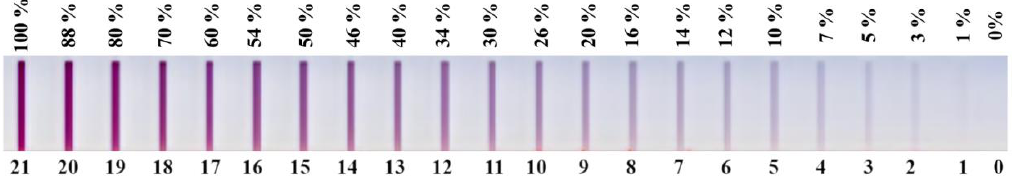
Figure 1. Color intensity scale of the STANDARD Q COVID-19 Ag test (Q Ag) (SD Biosensor, Suwon, Korea). The color intensities that appeared on the test kits were compared with the color scale and were recorded within the range of 0 to 21 as negative to very strong, respectively.